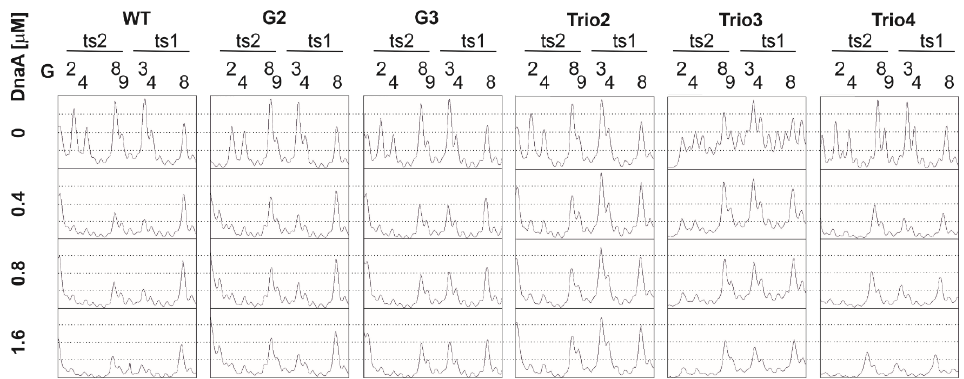
Figure 5. Densitometric analysis of the DMS gels (Figure 3) presenting disturbed DnaA interaction with DnaA boxes at the mutated oriC2 ; WT oriC2 is shown as a control. The concentrations indicated next to the plots correspond to the analyzed lanes. The protected guanine residues (G) and the protected positions within each DnaA box are indicated above the plots.